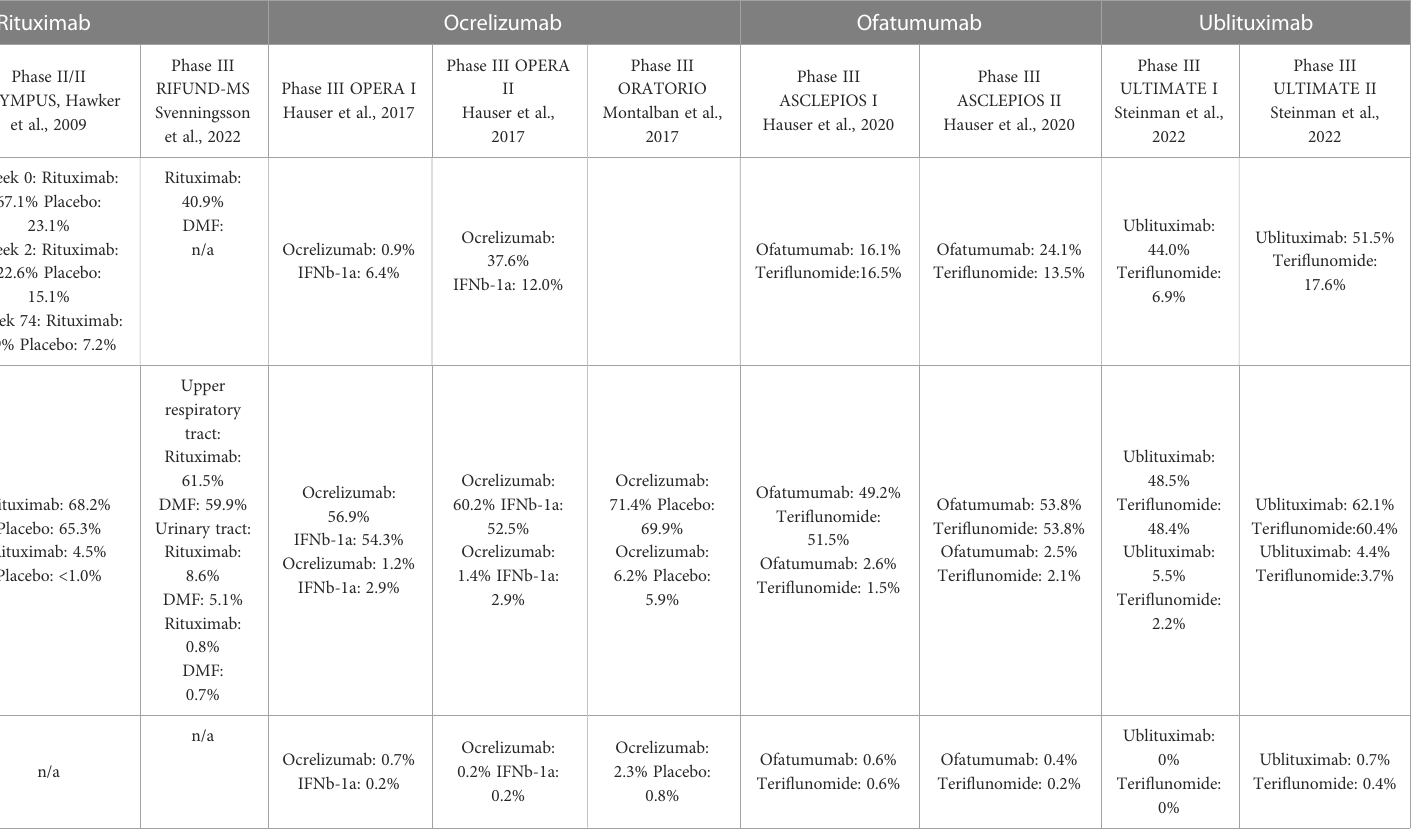
TABLE 4 Most common adverse events observed with rituximab, ocrelizumab, ofatumumab and ublituximab in phase II/III